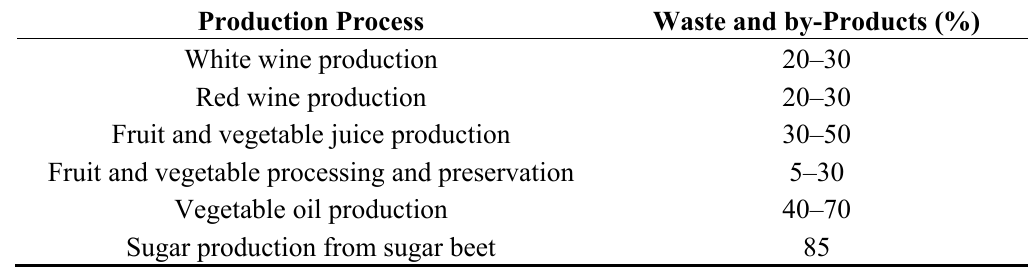
Table 1. Percentage of food wastes and by-products in fruit and vegetable production